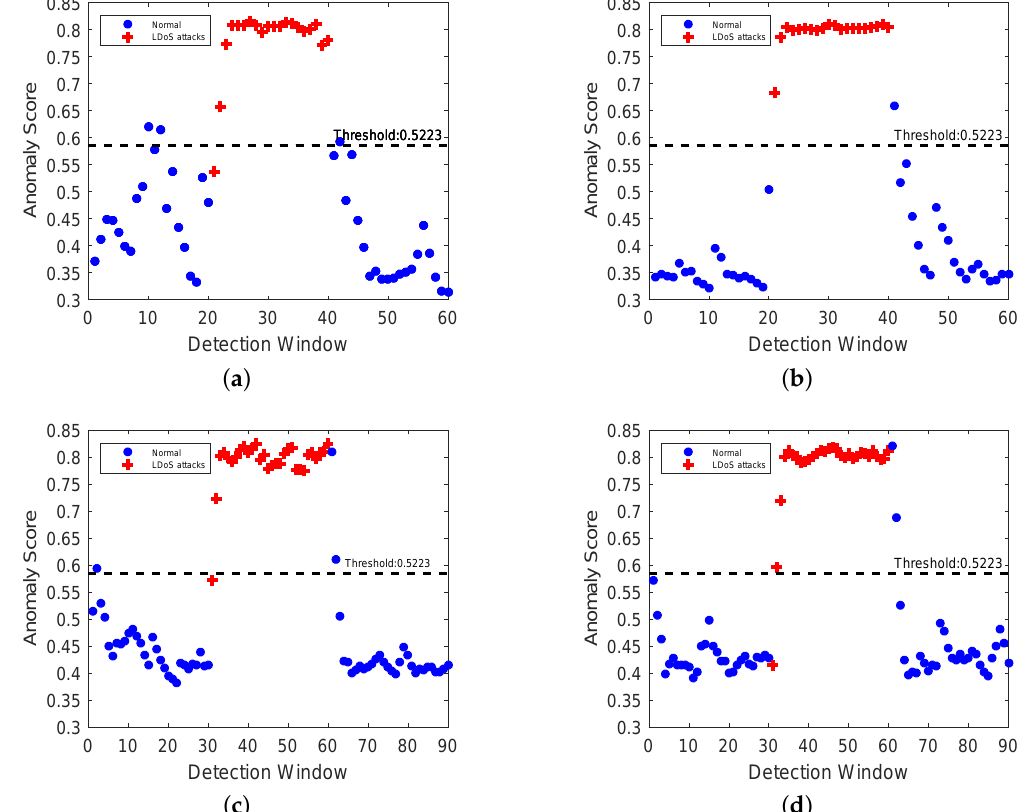
Figure 14. Detection results of four groups in testbed: ( a – d ) are corresponding to the detection results of G1, G2, G3, and G4 respectively.